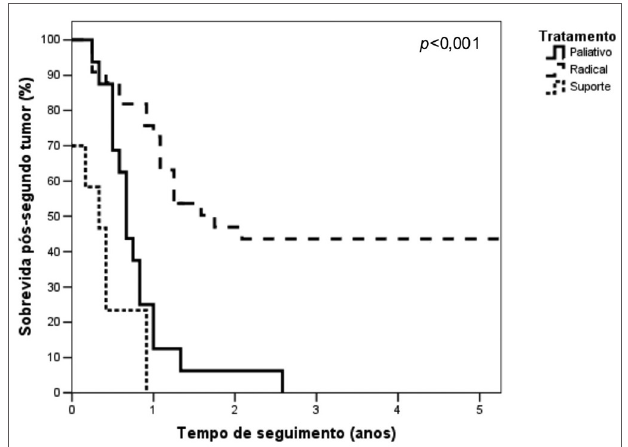
Figura 2. Curvas de sobrevida pós-segundo tumor primário de acordo com o tipo de tratamento do segundo tumor.